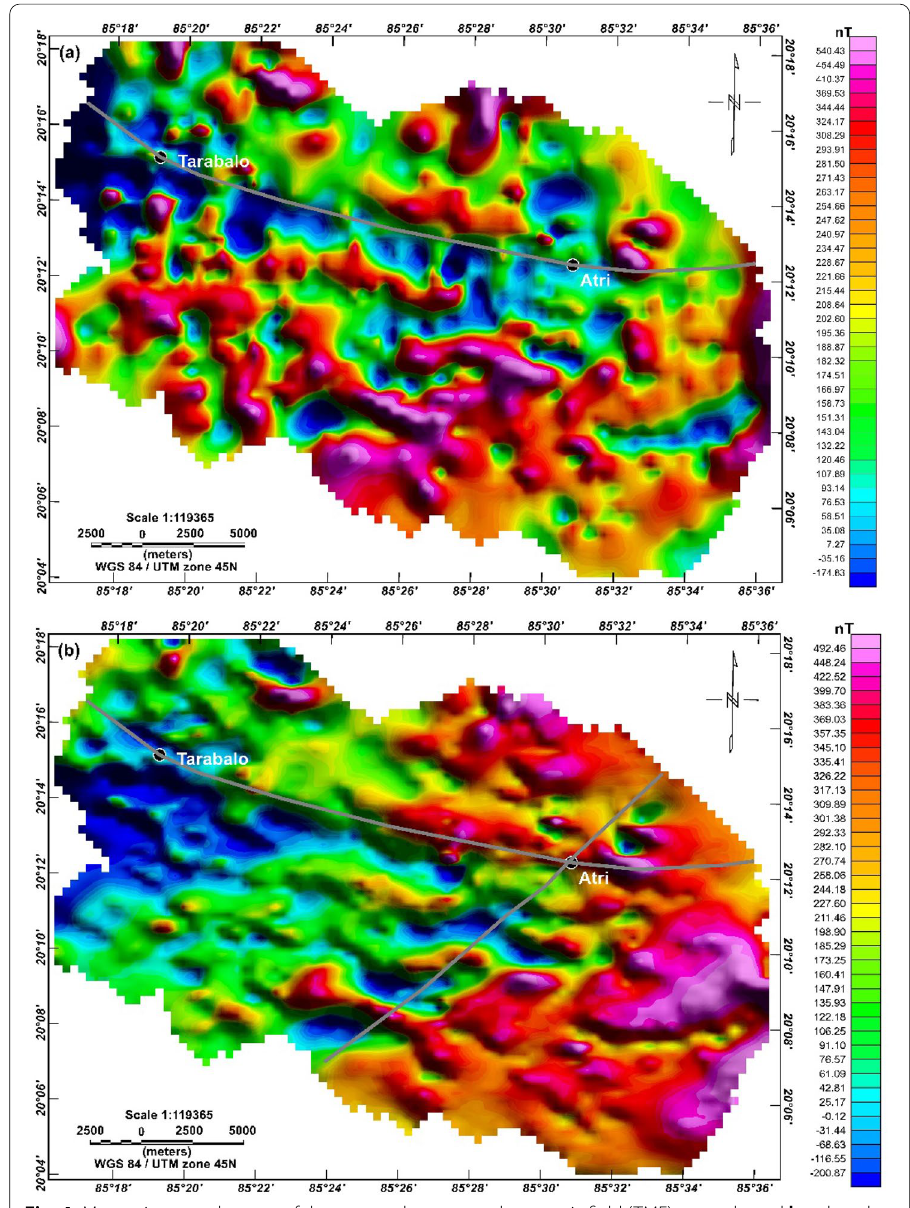
Fig. 4 Magnetic anomaly maps of the surveyed area: a total magnetic field (TMF) anomaly, and b reduced to equator (RTE) anomaly. Grey lines indicate the location of the faults in the